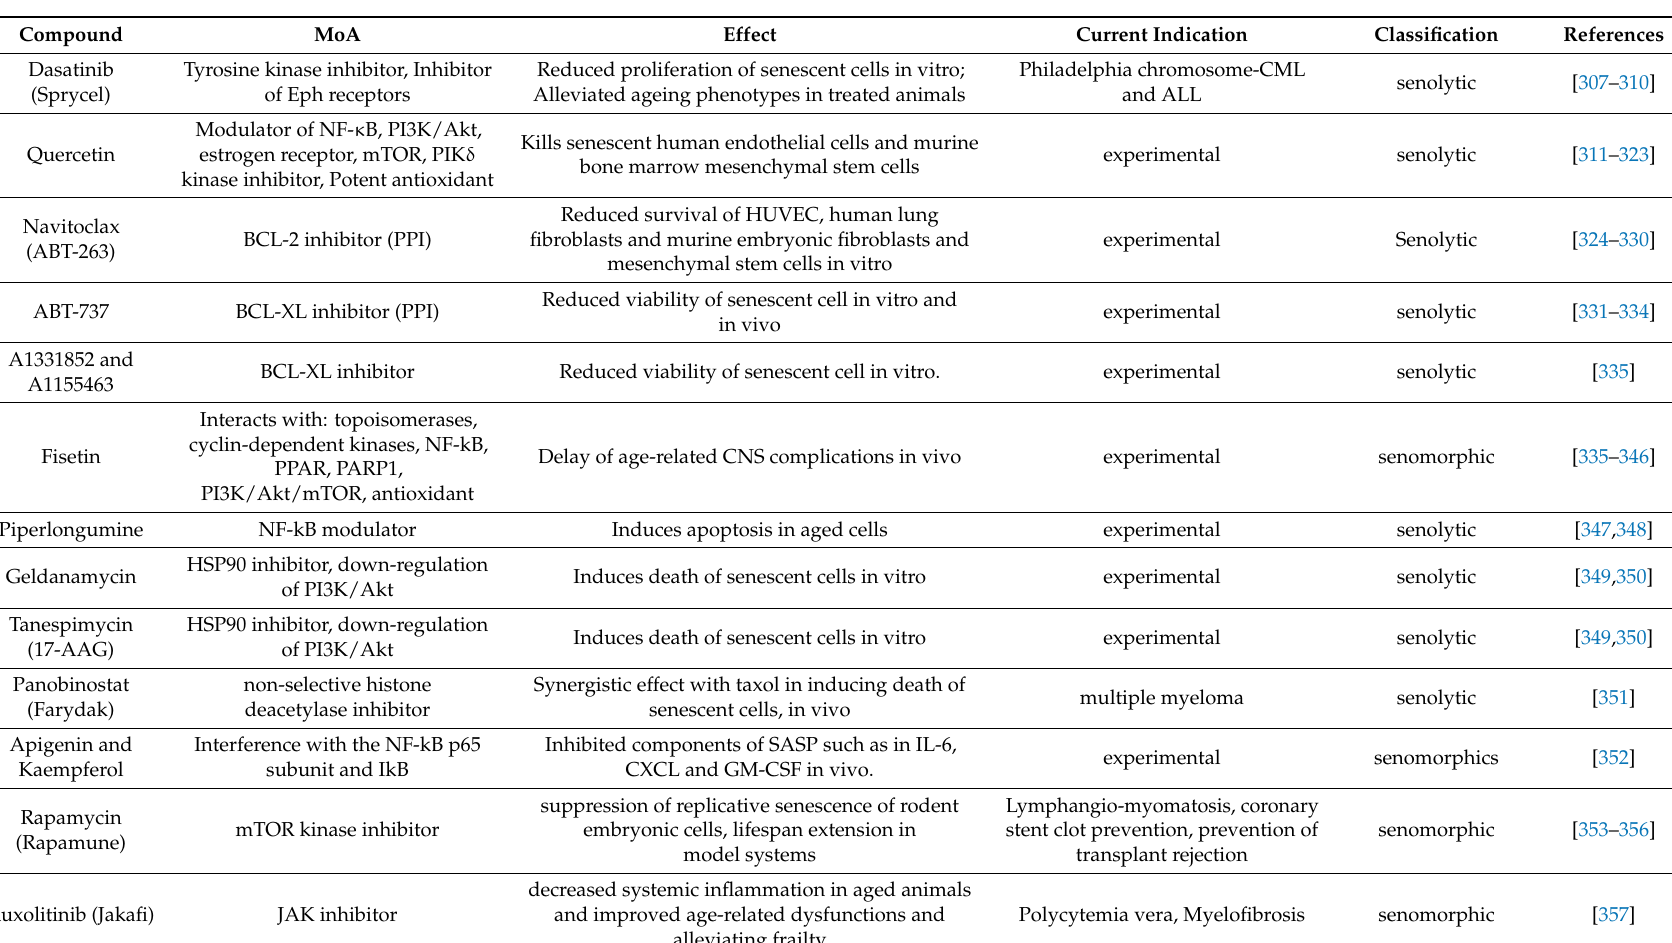
Table 1. Licensed and experimental compounds with senolytic, senomorphic or senescence-inducing action adapted from Myrianthopoulos et al., 2018 [303]. ALL: acute lymphocytic leukemia, CML: chronic myelogenous leukemia, HUVEC: human umbilical vein epithelial cells, JAK: Janus kinsase, MEF: mouse embryonic fibroblasts, MoA: mechanism of action, PPI: protein-protein interaction